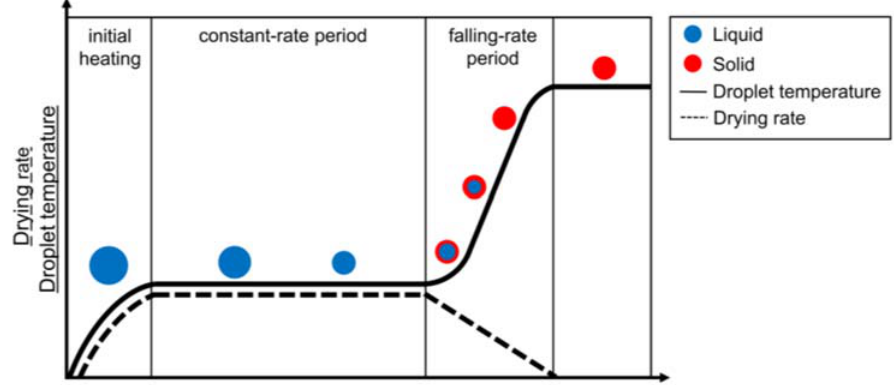
Figure 3. Schematic representation of droplet drying kinetics of a single droplet during the spray ‐ drying process. Reproduced from Boel et al. [33]. drying process. Reproduced from Boel et al.